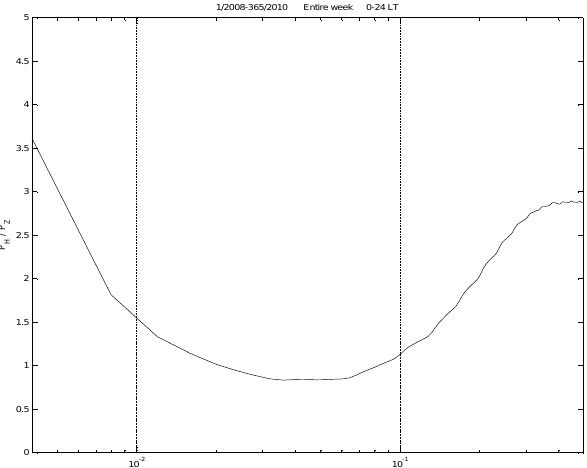
Figure 10. The ratio R HZ between the spectral density of the H and Z